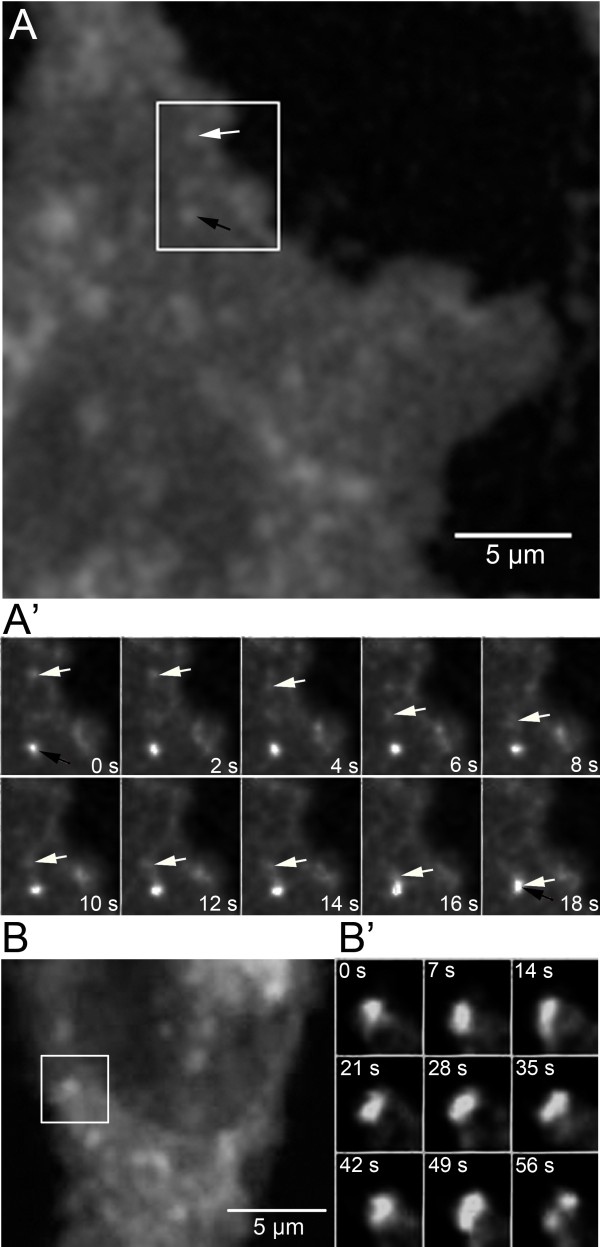
Two-photon time-lapse imaging of fusion and fission of vesicles containing BChol. CHO cells were pulse-labeled with BChol followed by a chase to obtain the steady-state distribution. The cells were placed on a temperature-controlled stage of a home-built 2P-microscope maintained at 35 ± 1°C, and images were acquired without pause at a frame rate of 1.05 s. We observed vesicle fusion (A’): one vesicle (white arrow) moved with a directed motion toward another vesicle (black arrow) over a period of 18 s. Further observation of the fused vesicle over 100 s did not show subsequent fission of the vesicle. We also observed vesicle fission (B, B’): over a period of ~1 min the vesicle was heavily stretched and deformed before it finally separated into two vesicles with lower fluorescence intensity.